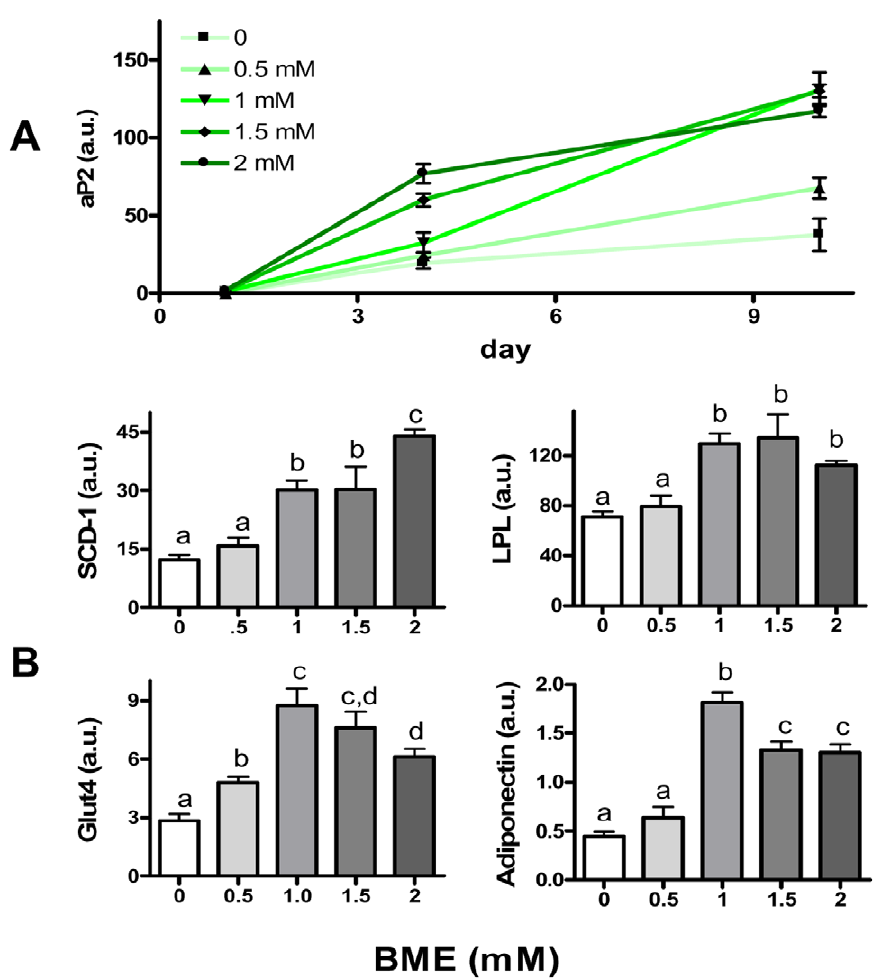
Figure 3. BME increases expression of adipogenic genes. A : The time course of aP2 mRNA expression in F442A cells after being induced to differentiate by insulin and fetal bovine serum and graded concentration of BME. B : Messenger RNA for SCD-1, LPL, Glut4, and adiponectin on day 10 of differentiation after being co-treated with graded concentration of BME. Results are means + / 2 SE (N=3–6). Columns denoted with non-identical alphabets are statistically different (p , 0.05, by Tukey’s test).